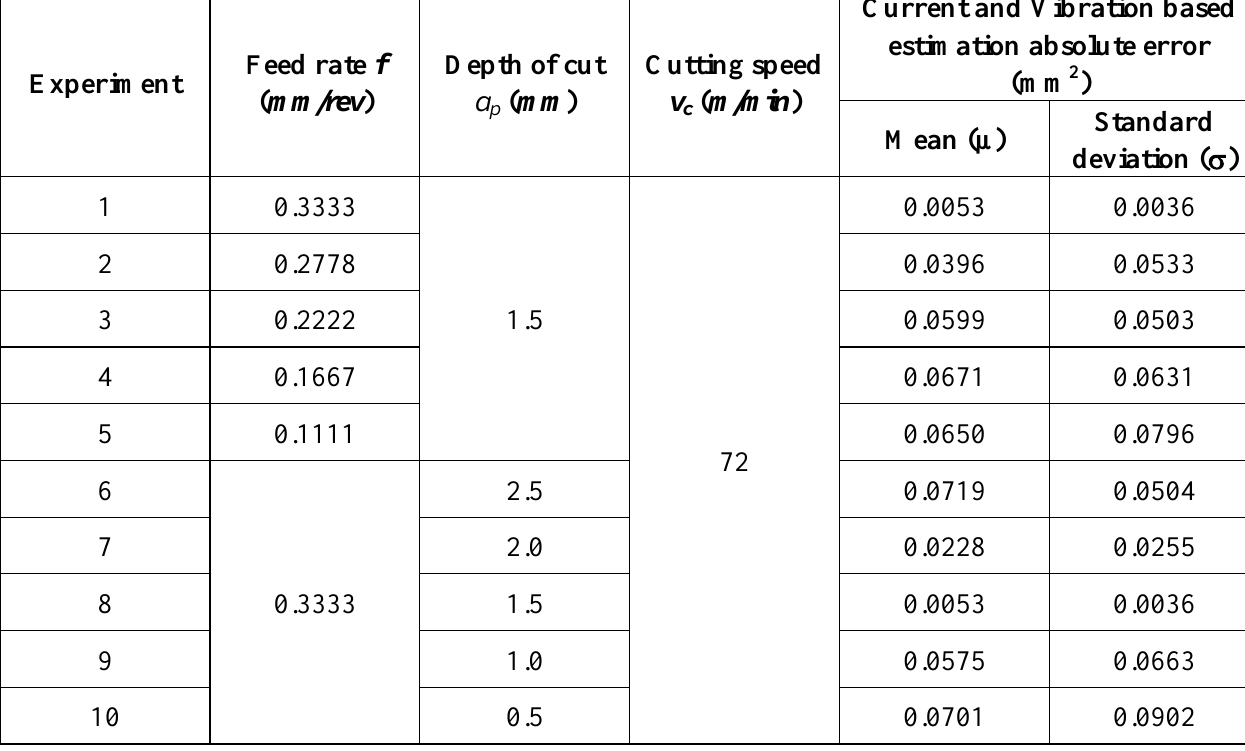
Table 3. Smart sensor tool-wear area estimation errors for different machining